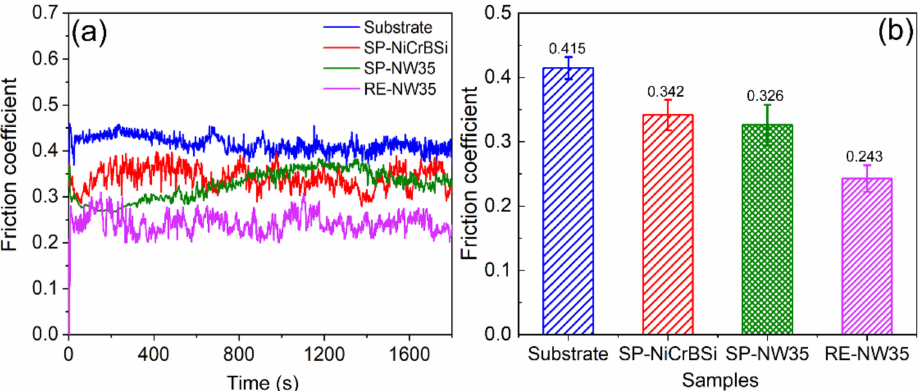
Figure 5. ( a ) friction coe ffi cient curves and ( b ) their average values at 600 ◦ C of SP-NiCrBSi, SP-NW35 and RE-NW35 coating samples.